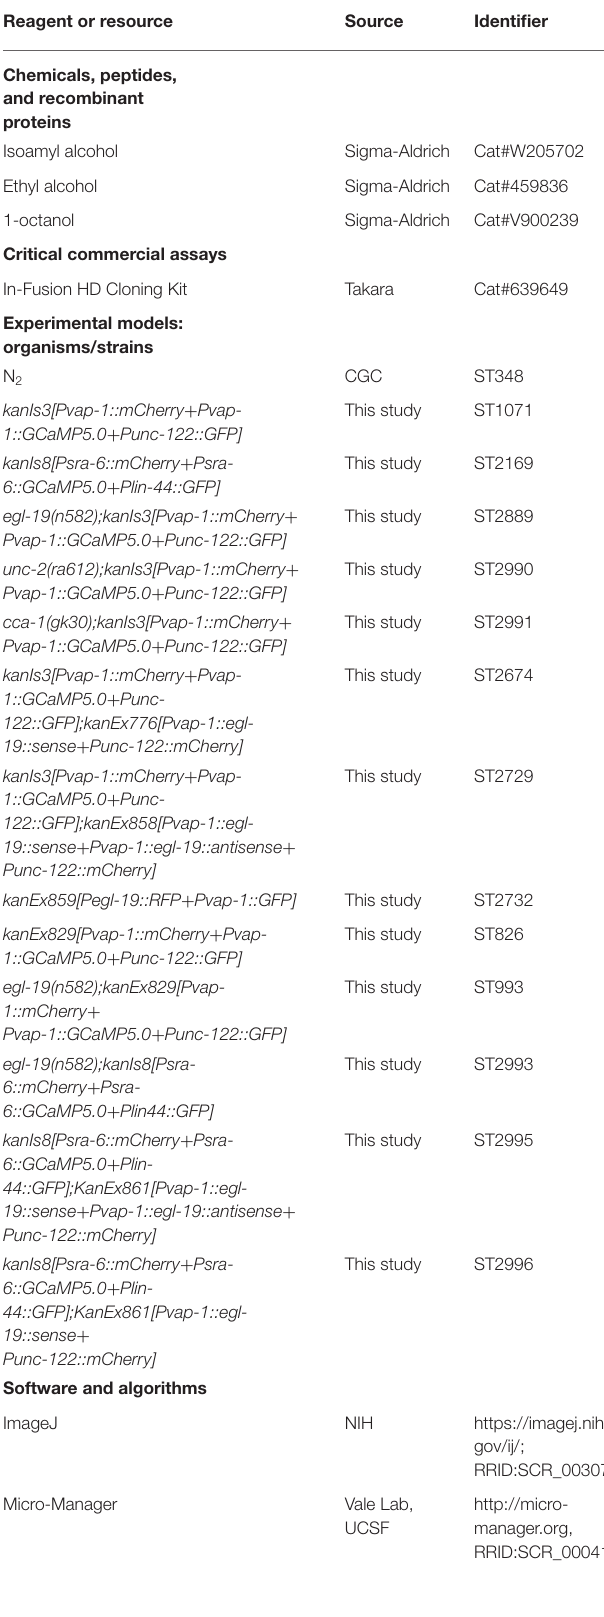
TABLE 1 | Key resources table. Reagent or resource Source Identifier Chemicals, peptides, and recombinant